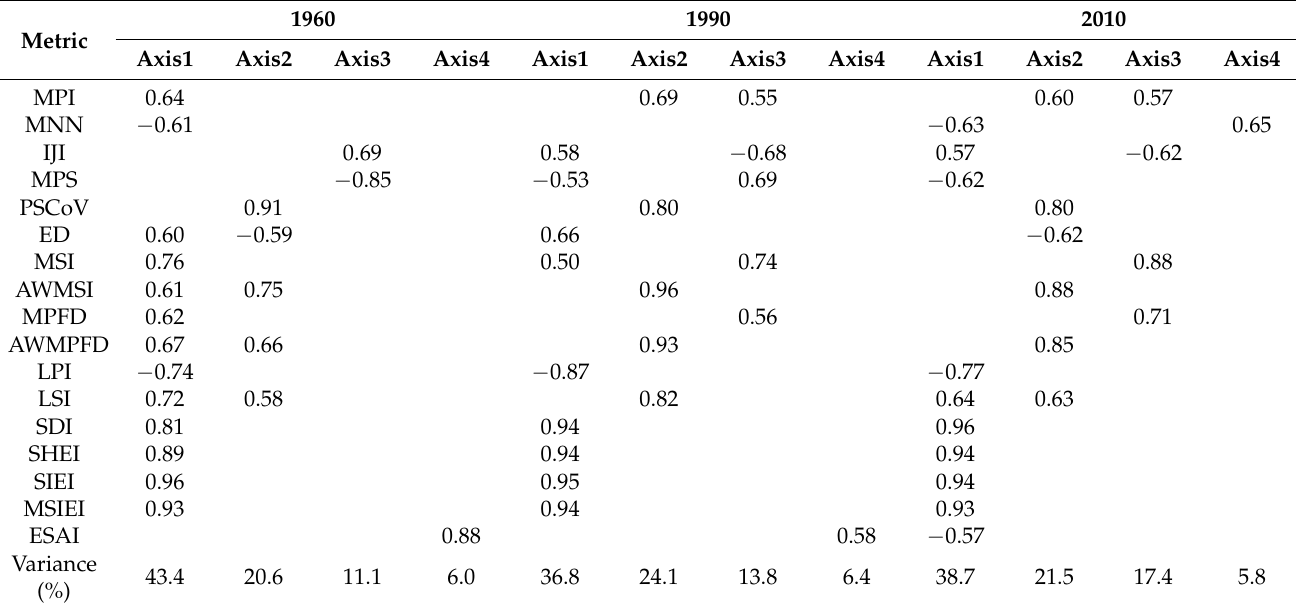
Table 2. Results of a Multiway Factor Analysis run on the full set of landscape metrics (see Table 1 for acronyms) considered in this study at the provincial scale in Italy, by year; only significant loadings were reported